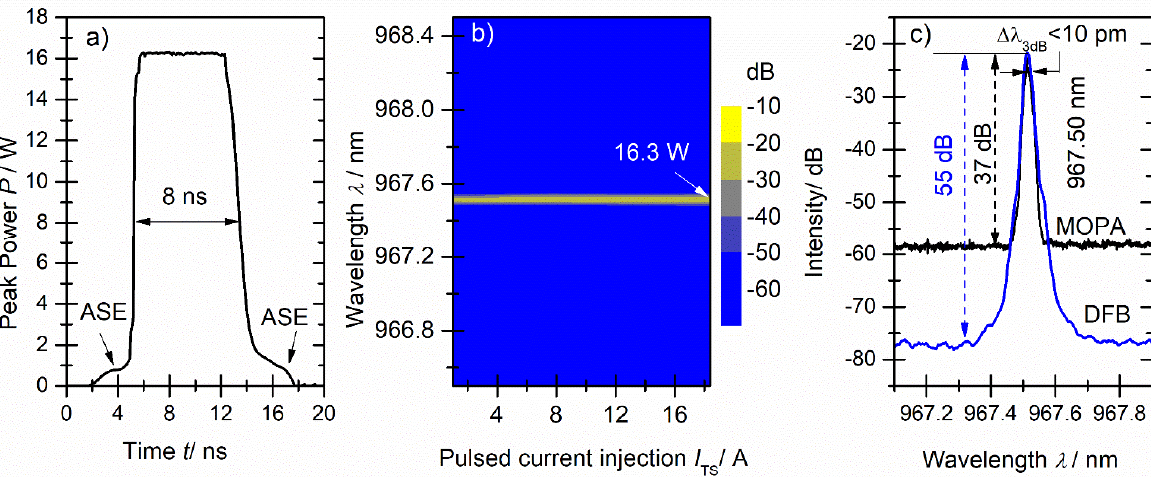
Figure 6. ( a ) Temporal behavior of the optical power emitted by the MOPA system at a seed wavelength of 967.50 nm ( I G1 = 130 mA, I G2 = 0 mA). ( b ) Color-scale mapping of the time-averaged optical spectrum of the MOPA in dependence of the amplitude of the current pulses injected into the TS for a fixed DFB laser current of I G1 = 0 mA, I G2 = 130 mA. ( c ) Comparison between the optical spectra of the DFB laser and the MOPA system for I G1 = 0 mA, I G2 = 130 mA and I TS = 18.4 A.